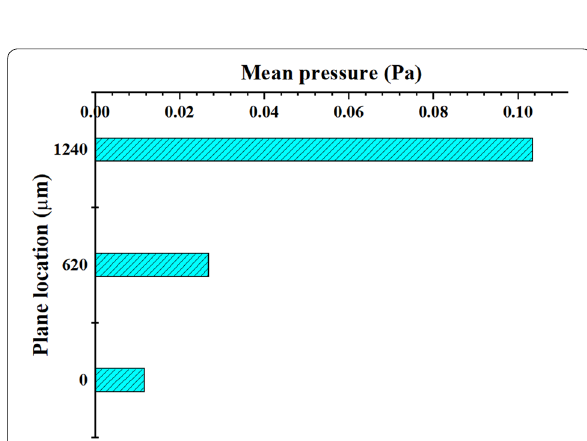
Figure 11 Mean pressure in the three planes obtained using CFD simulation (the pore diameter is 434 μm)